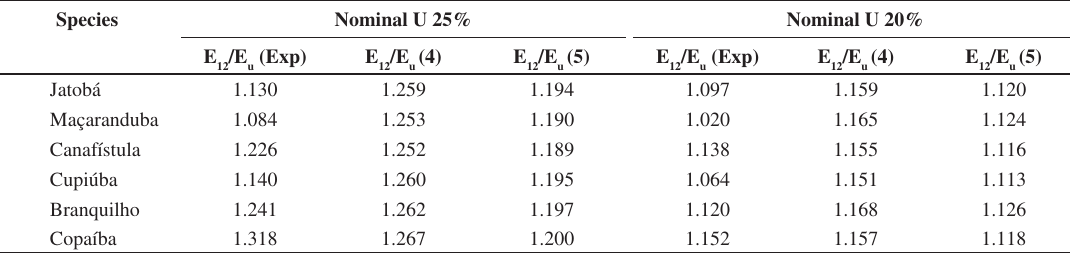
Table 4. E12/Eu ratios for the experimental results (Exp) and estimated by Equations 4 and 5 for the six species studied. Species